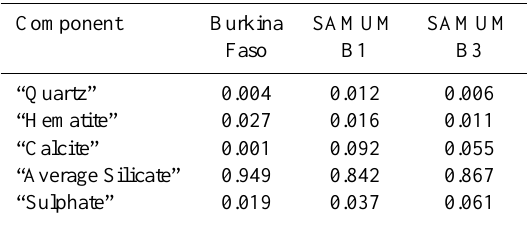
Fig. 3. Size-resolved composition of the re-dispersed soil samples. The numbers above the single bars show the number of analysed single particles in this size interval. Particles are weighted according to their volume inside the single size intervals. Table 4. Relative volume abundance of model substances derived from single particle analysis. The particle number of SAMUM B2 was not sufficient for such an